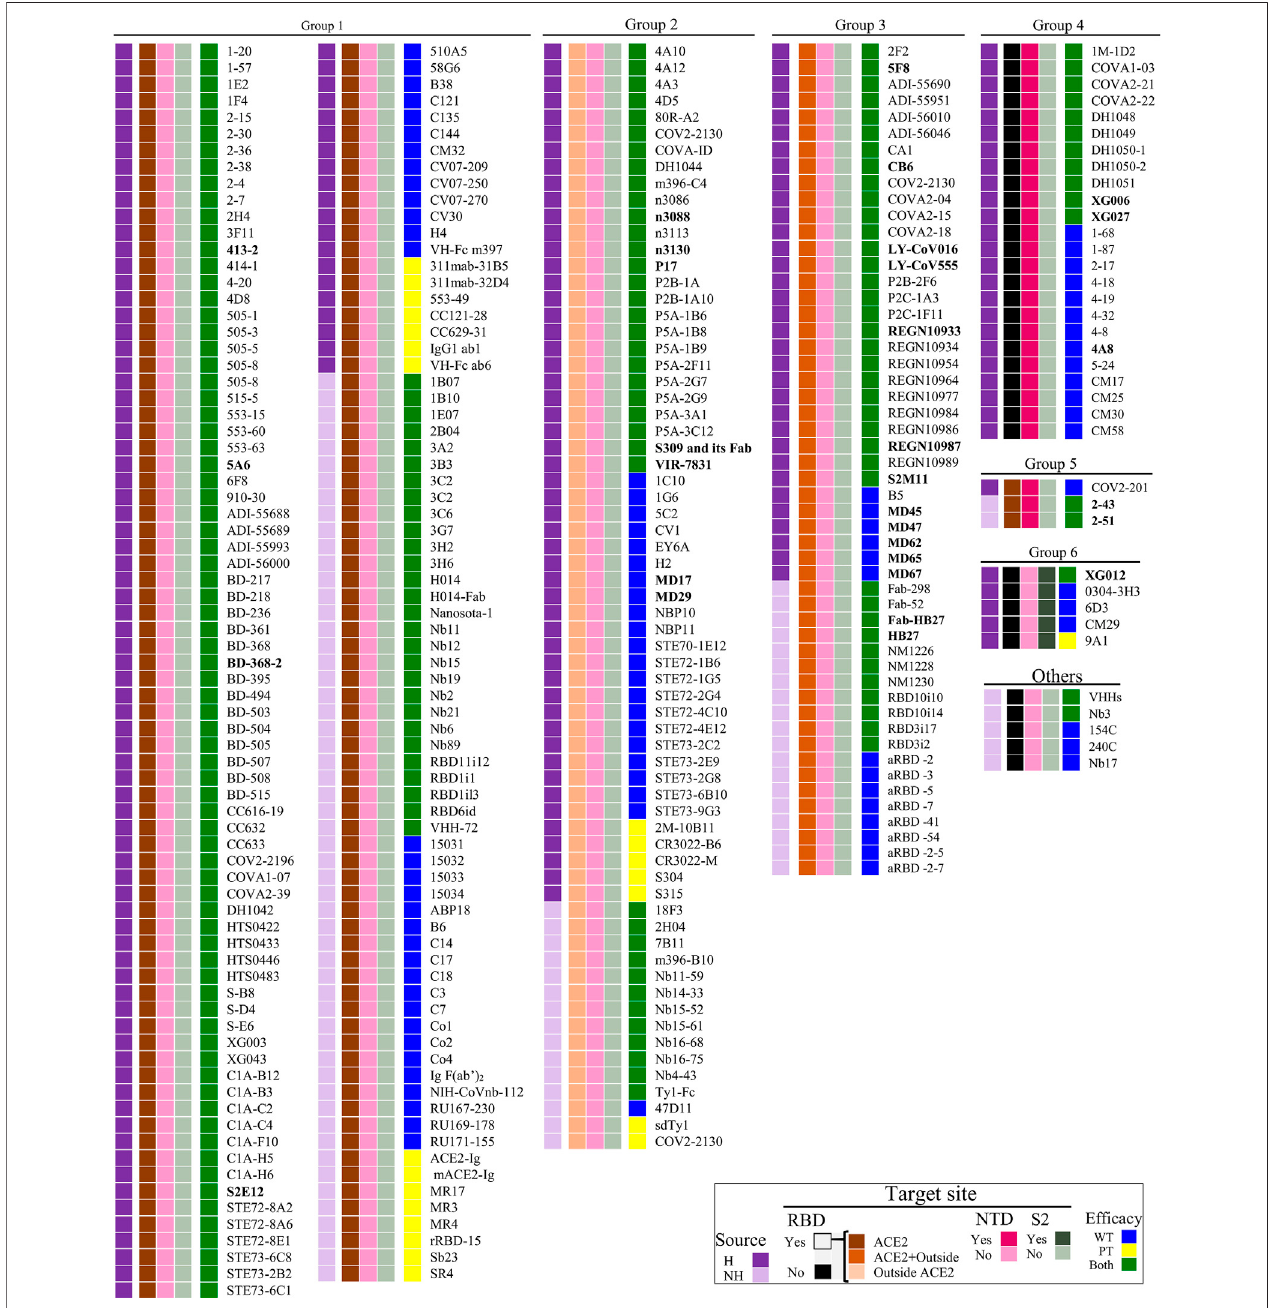
FIGURE1| Potential target site-based SARS-CoV-2NmAbsclassi fi cation. H,Human NmAbs; NH,non-human NmAbs;ACE2, angiotensin-convertingenzyme2; NTD, N-terminal domain; WT, wild-type SARS-CoV-2; PT, pseudotyped SARS-CoV-2 (right squares). NmAbs in bold font are the potential antibodies we suggest in Figure 4 to consider in the cocktail formulation. The functions of represented NmAbs groups are described hereinbefore and illustrated in Figure 2C .